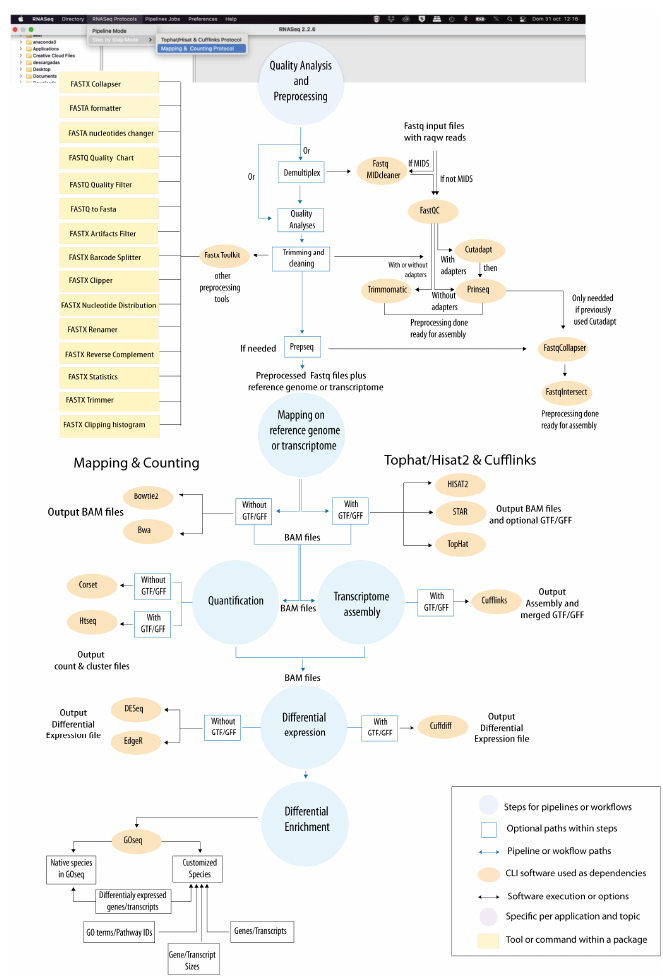
Figure 3. “ RNASeq ” protocol. Computational steps constituting the protocol of “ RNASeq ” for DE and enrichment analysis . The protocol is based on the following steps: “ Quality Analysis & Prepro- cessing ”; “ Mapping ”; “ Quantification ”; “ Transcriptome Assembly ”; “ Differential Expression ”; and “ Differ- ential Enrichment ”. A summary of all CLI tools available for each step is provided in the figure. Two